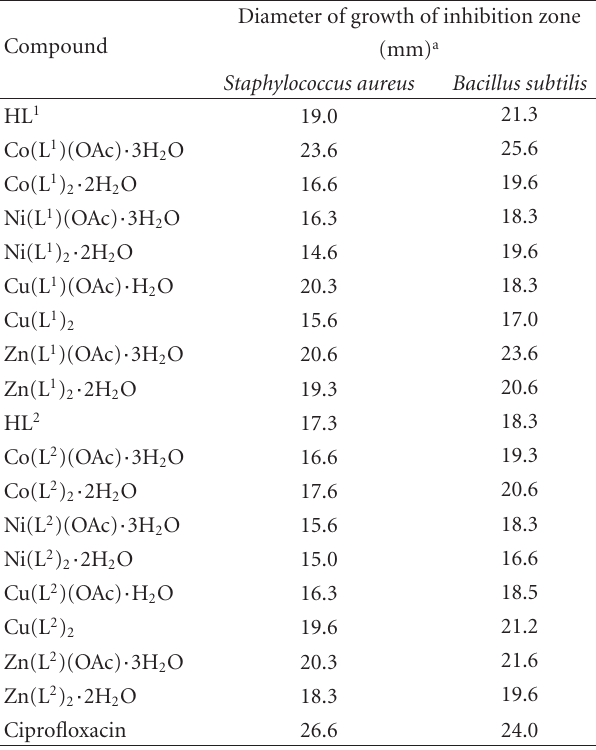
Table 7: Antifungal activity of synthesized compounds.